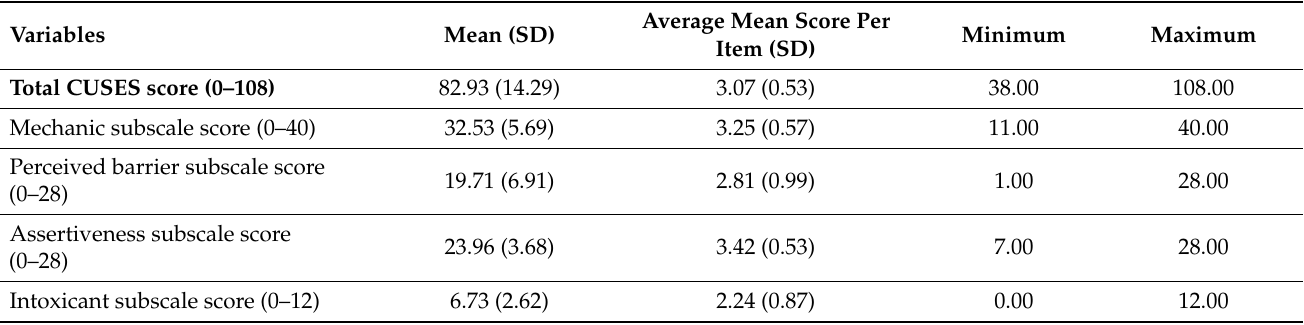
Table 3. The mean scores for condom use self-efficacy and its